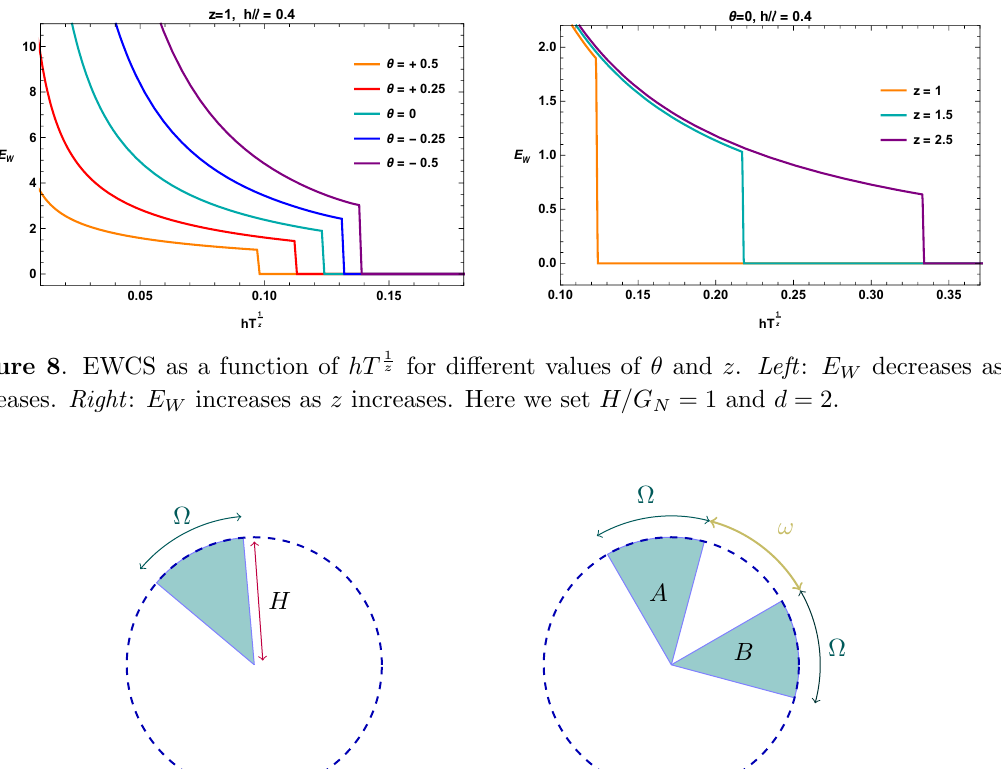
Figure 9 . Schematic con(cid:12)guration for computing HEE (left) and EWCS (right) in d = 2 when the entangling region contains a